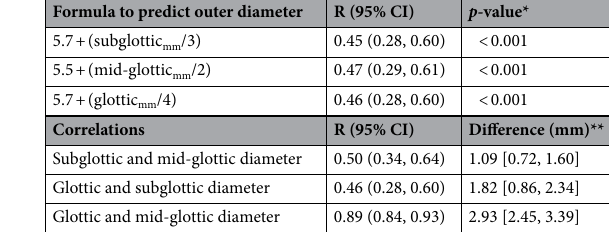
Table 3. Formulae of subglottic diameter, mid-glottic and glottic transverse diameter to predict outer diameter of endotracheal tube size and the correlations among them (N = 95). CI confidence interval. *Pearson’s correlation. **Median [interquartile